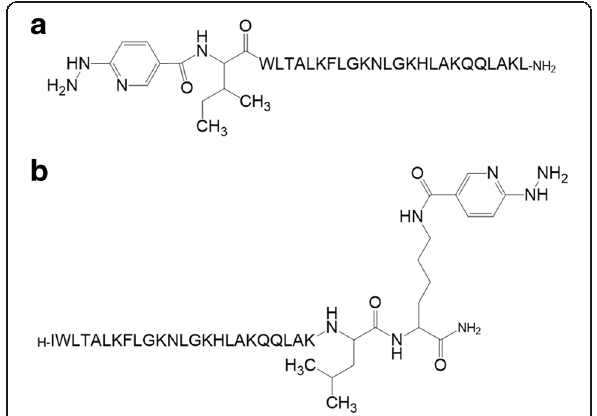
Fig. 1 Structures of the peptide LyeTx I derivatives modified with the chelating agent HYNIC. a HYNIC-LyeTx I derivative (M w =2966 g . mol − 1 ) and b LyeTx I-K-HYNIC derivative (M w =3094 g . mol − 1 ). – NH 2